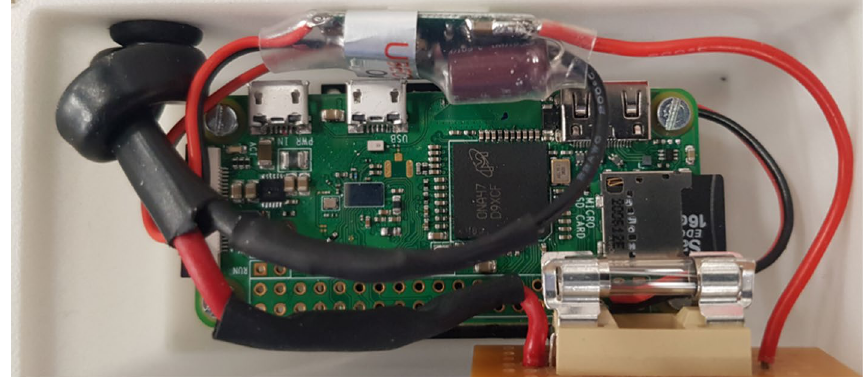
Fig. 6 Internal circuitry of the camera unit (as viewed from the top)